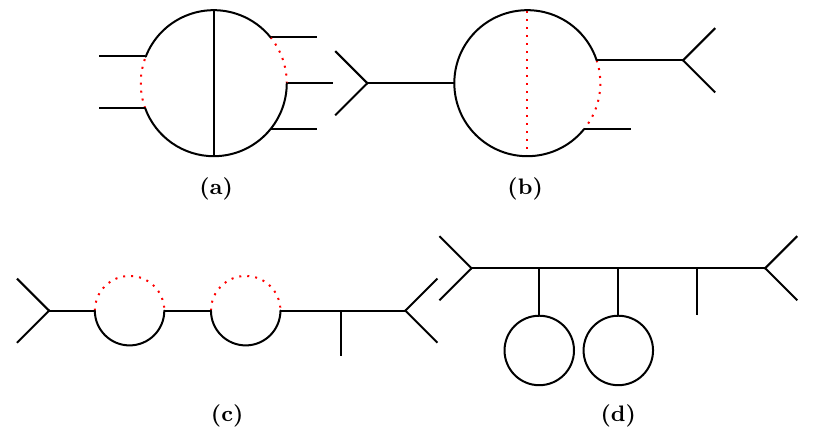
Figure 14. An example cubic graph with n = 5, g = 2 (Figure 14a) and the intermediate graphs ((cid:12)gure 14b, (cid:12)gure 14c) obtained via duality transformations in order to put it in the canonical form ((cid:12)gure 14d). In (cid:12)gures 14a{14c, edges drawn with red dots are those which are duality-transformed to arrive at the successive